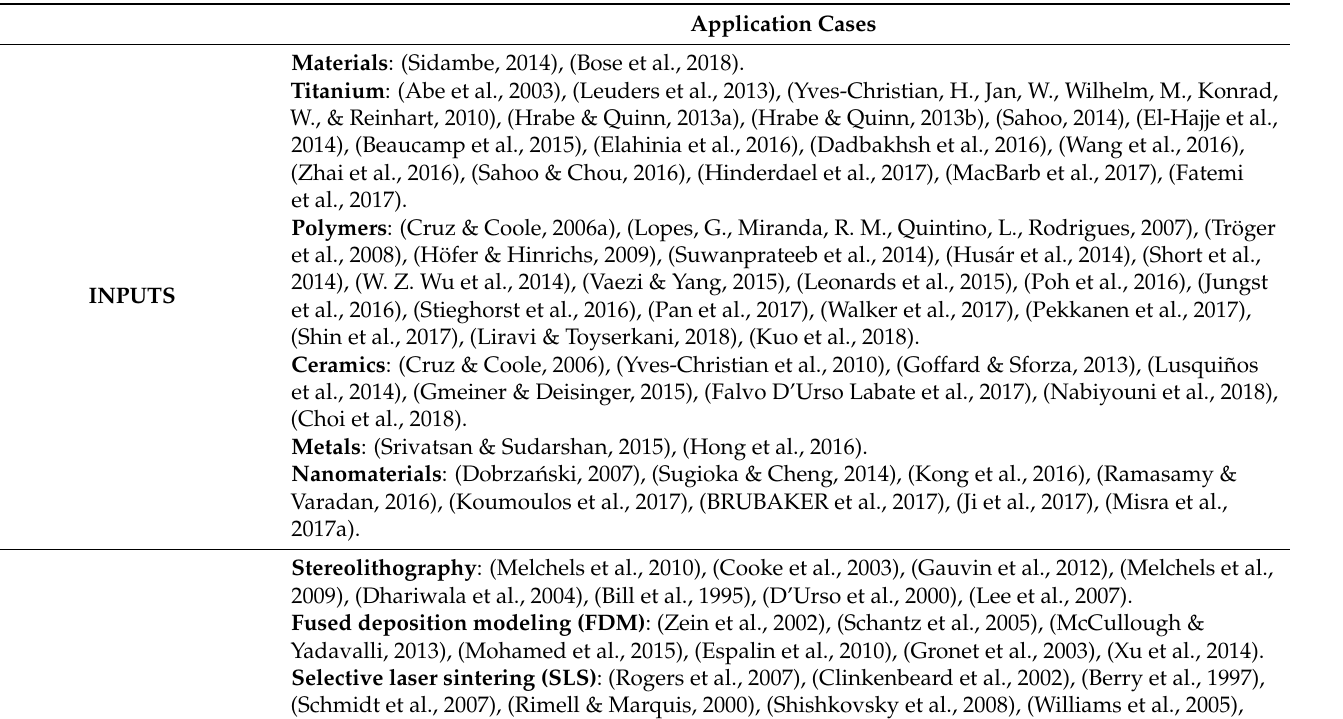
Table 2. Additive manufacturing process in the health